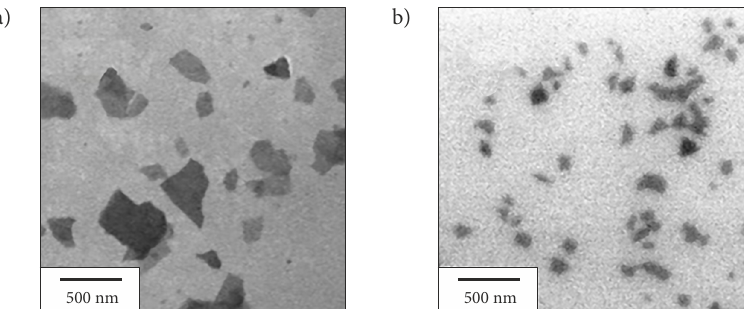
Figure 2. The SEM images of (a) 300 nm and (b) 100 nm of graphene oxide on silicon substrate